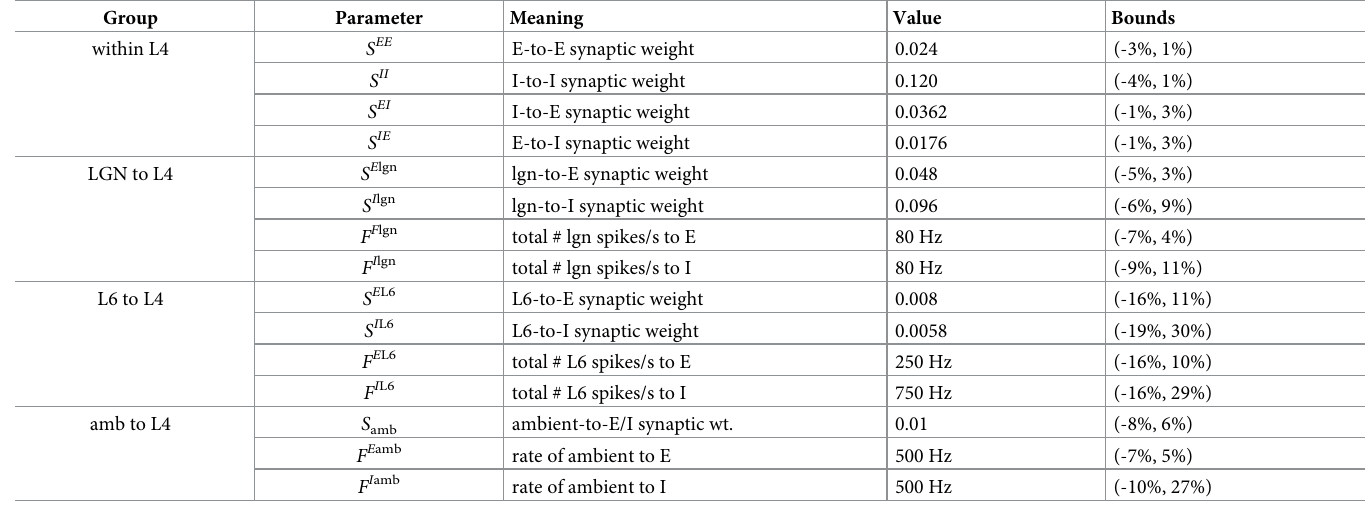
Table 1. Network parameters and response. Using the parameters from [41] as a reference point, we set ð f 0 � ; f ð Þj f E = f 0 2 2 ; 4 2 3 ; 4 : 5 ð Þg = ð and vary one parameter at a time. We then compute the minimum perturbation needed to force the network firing rates out of = Þ ; f I = f f 3 3 E I E E F . Values such as F E P , where P 2 {lgn, L6, amb}, represent the total number of spikes per second received by an E-cell in L4 from source P . For example, in the reference set, each L4 cell has 4 afferent LGN cells on average, the mean firing rate of each is assumed to be 20 spikes/s, so F E lgn = 80 Hz. Column 5 gives the lower and upper bounds of single-parameter variation (rounded to the nearest 1%) from the reference point that yield firing rates within F